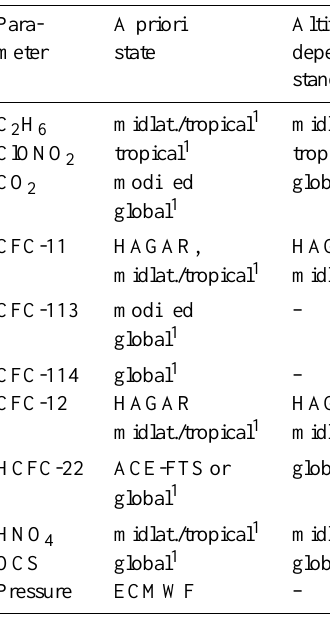
Table 4. Forward model